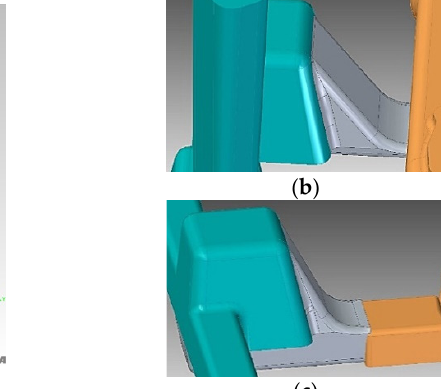
Figure 7. Stage 1 ( a ) Oxide impurities; ( b ) porosity in the areas marked in Figure 5a (LM).